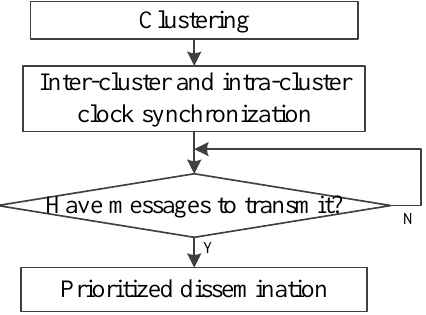
Figure 7. The overview of PDMAC.